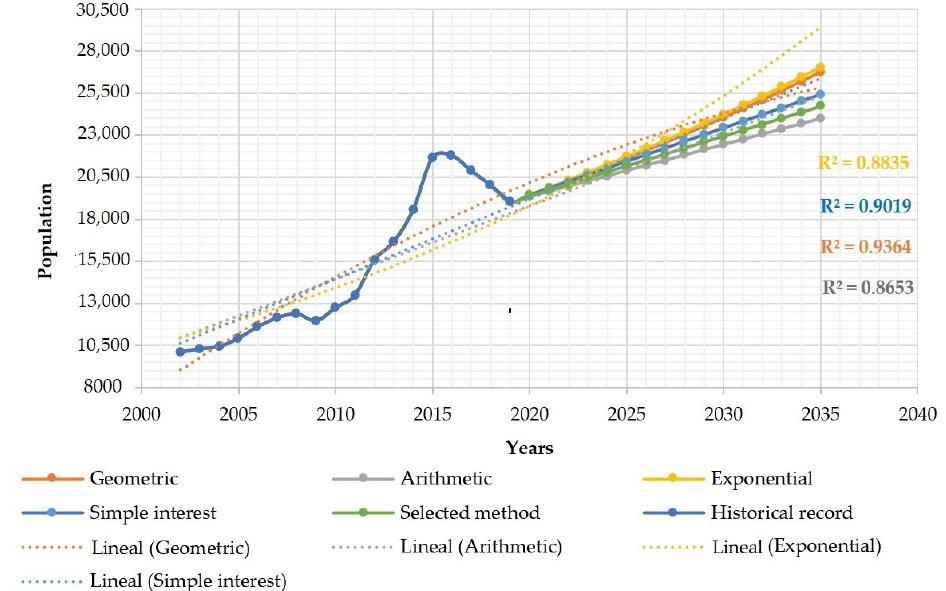
Figure 10. Population projection curve.